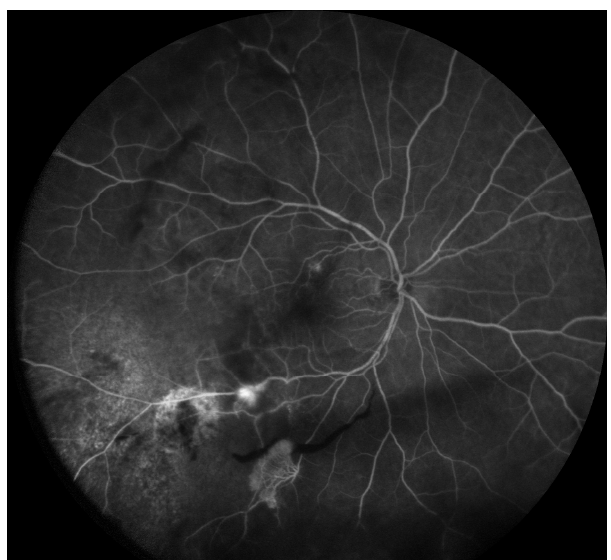
Figure 6. Fluorescein angiography imaging demonstrating retinal neovascularization along the inferior temporal vascular arcades bordering ischemic areas.